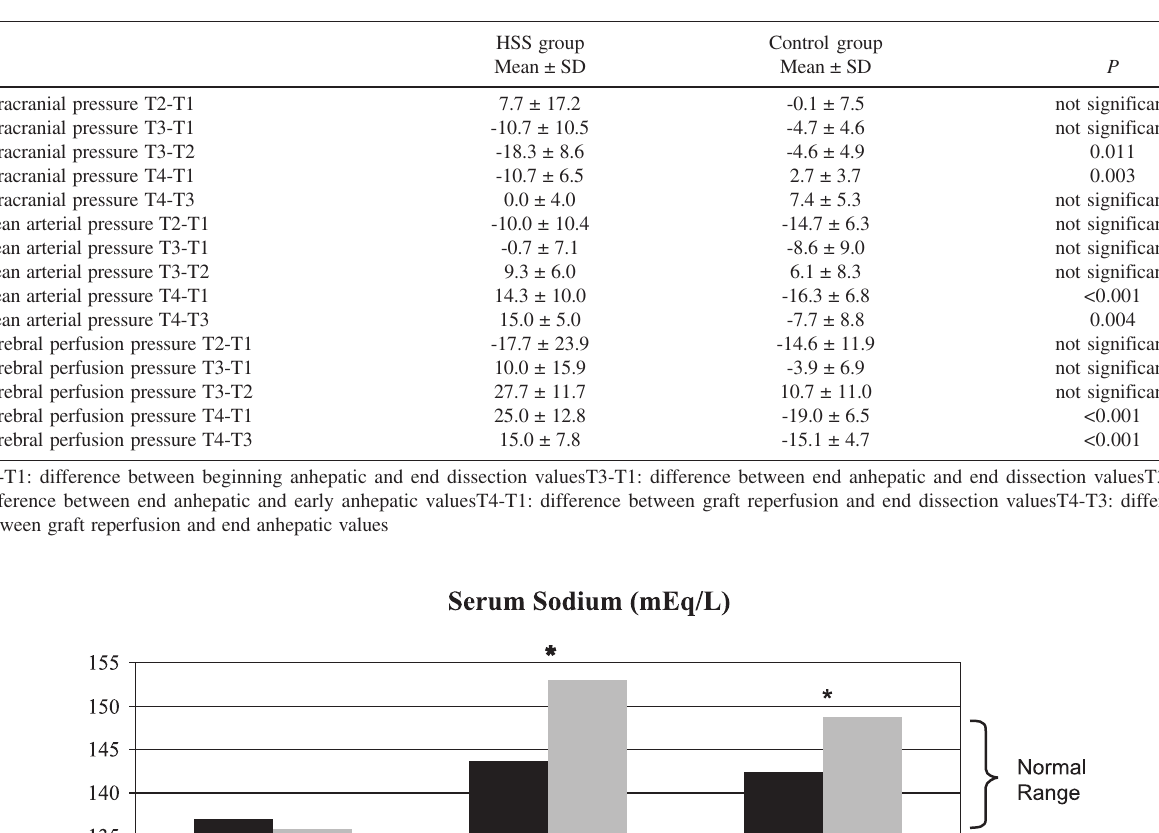
Table 2 - Mean Systemic and Cerebral Hemodynamic Evolution (mm